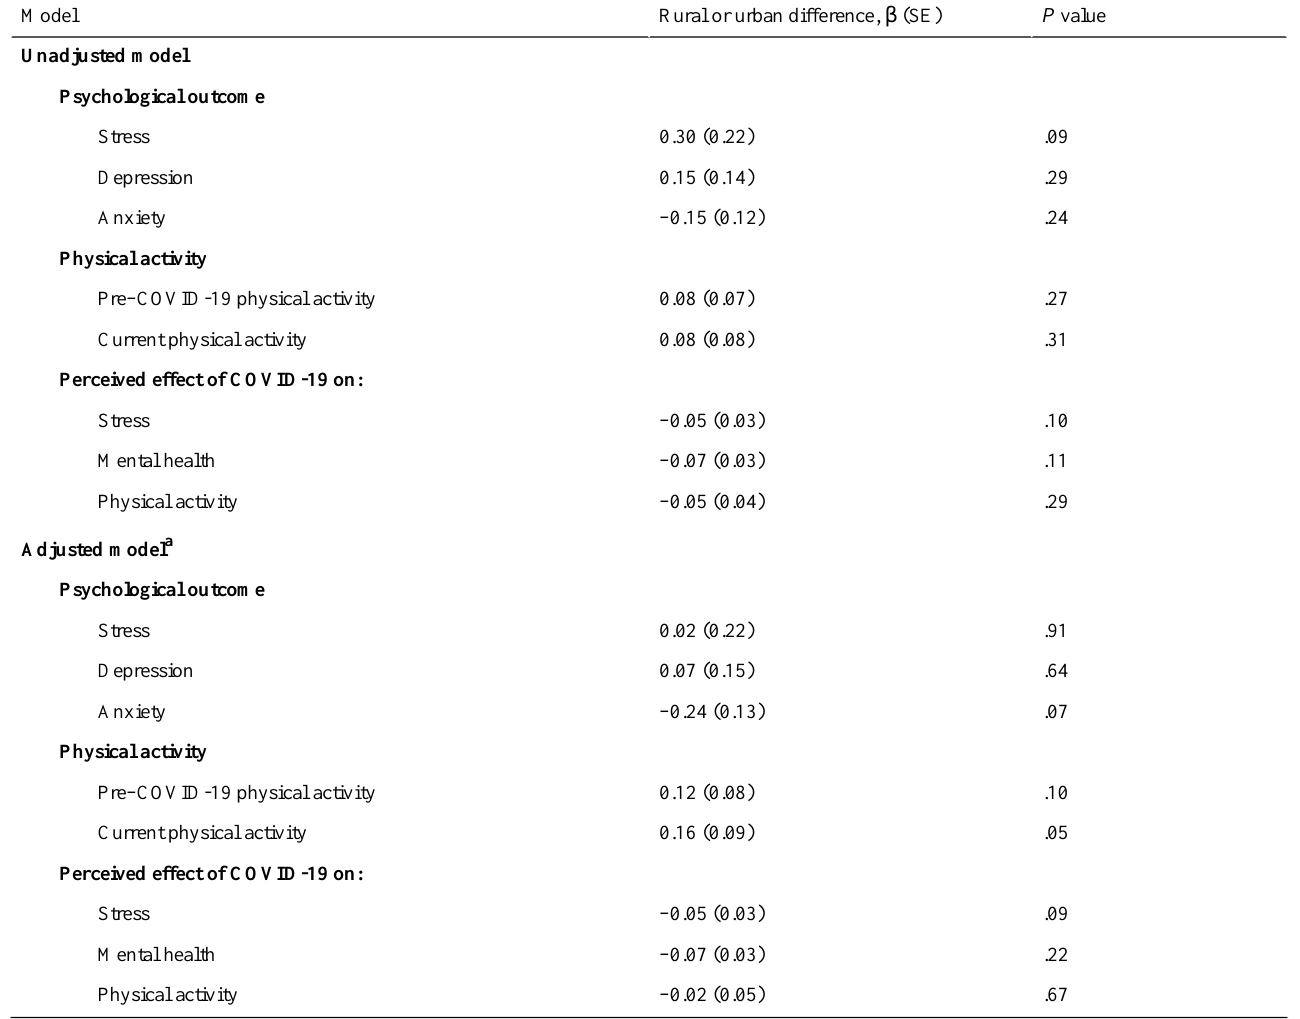
Table 3. Unadjusted and adjusted regression models exploring associations between rural or urban status and psychological outcomes, physical activity, and perceived effects of